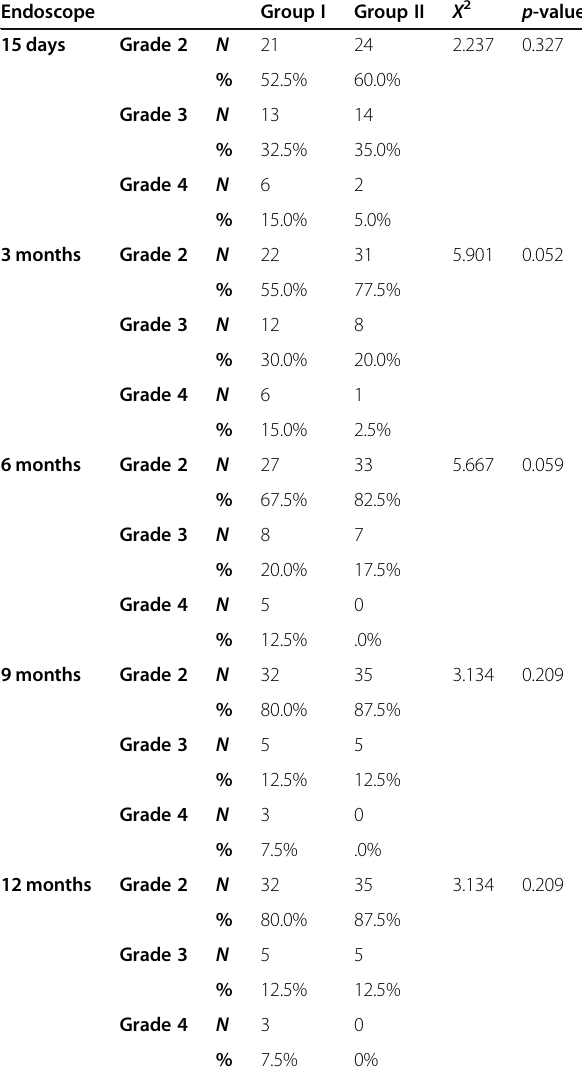
Table 3 Endoscopic finding of the two studied groups